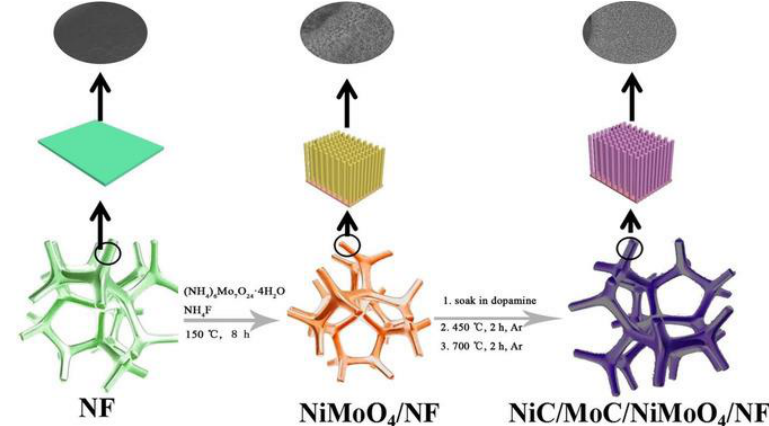
Figure 2. Schematic illustration of the synthesis process for NiC/MoC/NiMoO 4 /NF. Reproduced with permission from [46]. Copyright 2019 Chemistry-An Asian Journal .